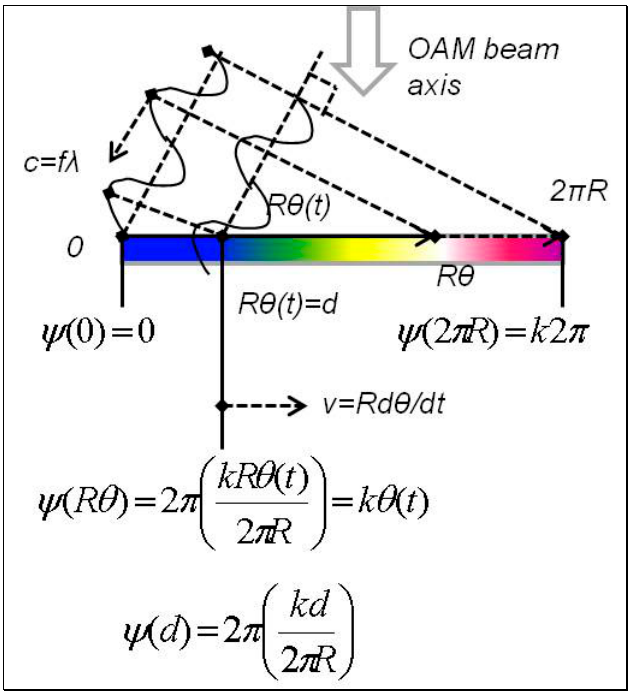
Figure A2. Derivation of transverse-type, or rotational Doppler effect in an OAM beam.